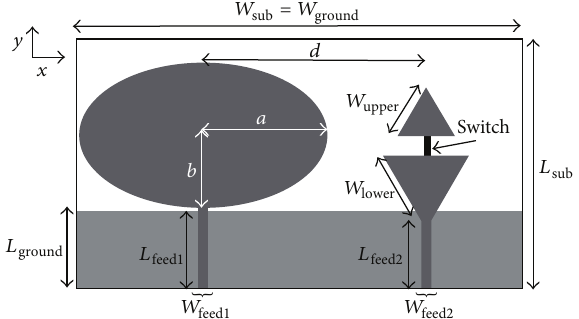
Figure 1: A proposed sensing and communicating antenna config- uration in [5].